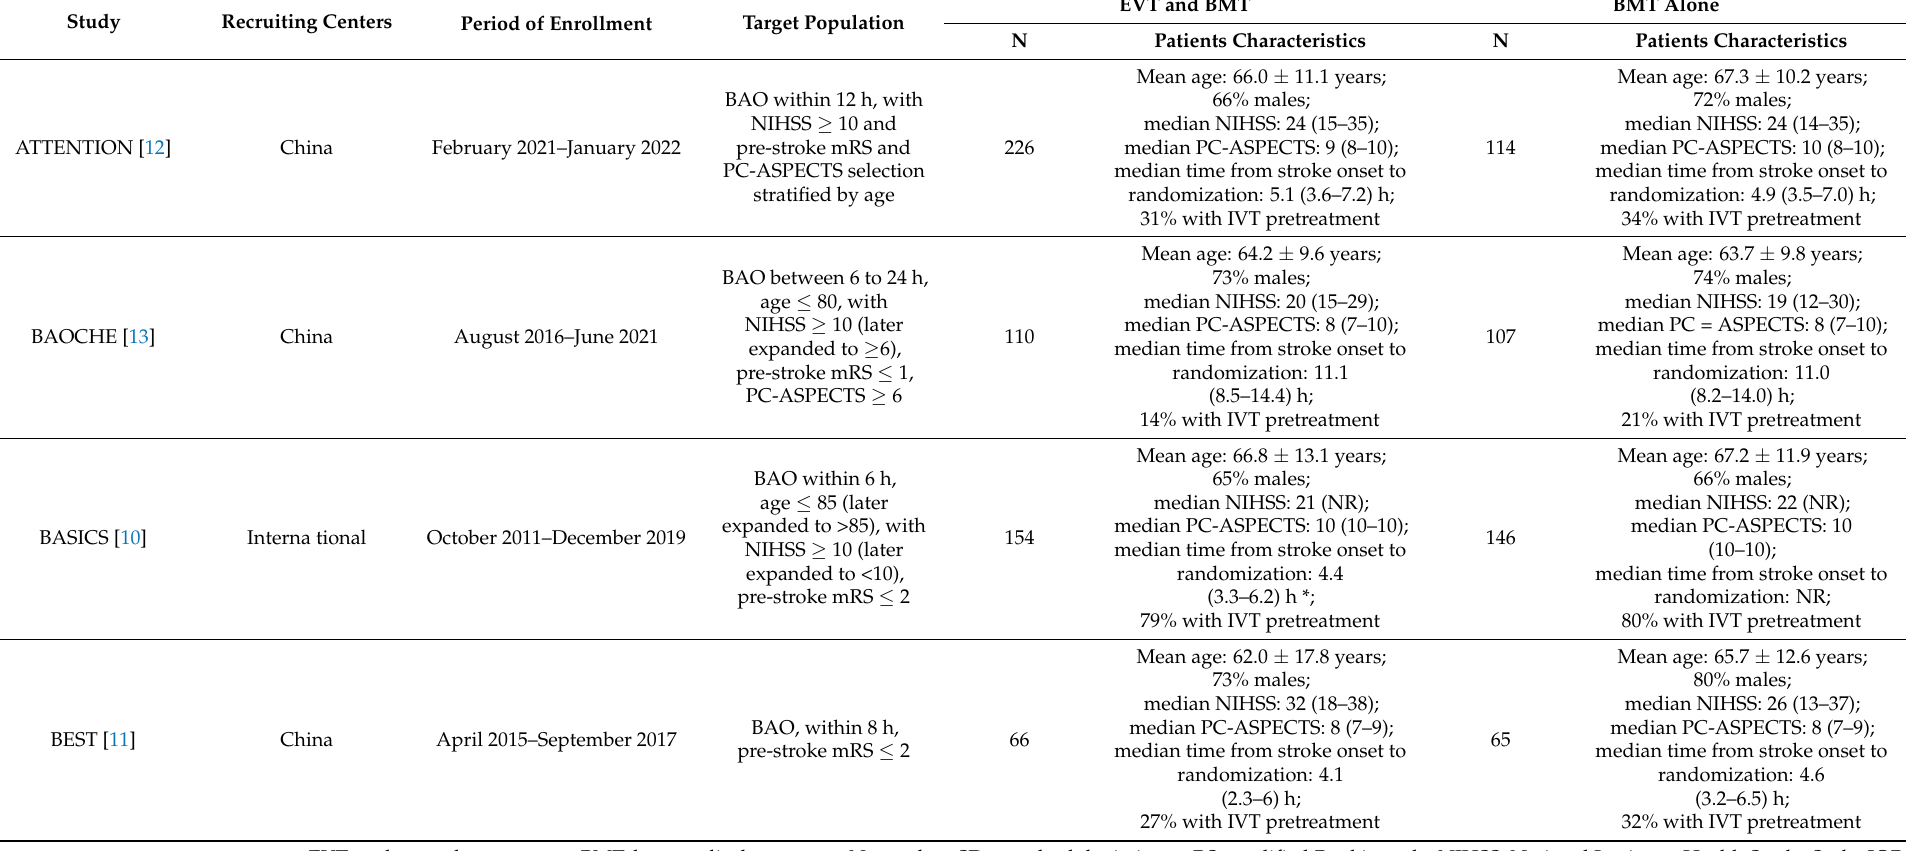
Table 1. Characteristics of studies included in the systematic review and